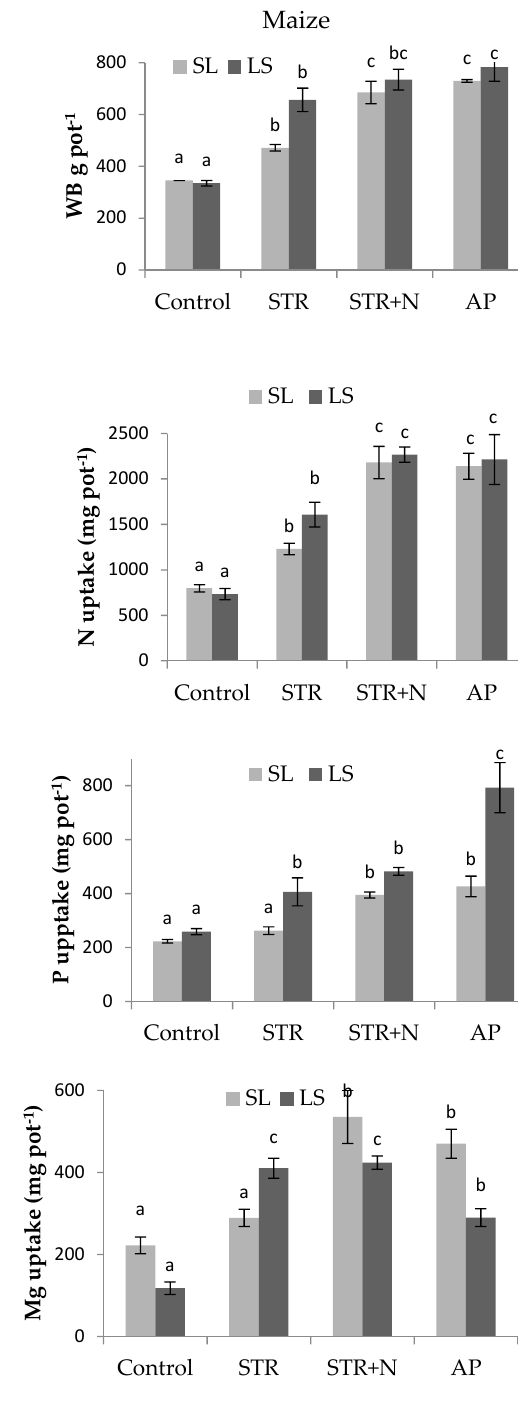
Figure 1. Yields (WB—Wet Basis) of maize and grass (sum of of three mowings) on two types of soil: silty loam (SL) and loamy sand (LS) and N, P, Mg uptake by crops on objects fertilized with: struvite from bio-refinery—STR; struvite from bio-refinery and ammonium sulfate (commercial)—STR + N; ammonium phosphate (commercial)—AP and on control treatment—without fertilization (Control). The standard deviation within each treatment (n = 3) is indicated by the line extending the column. (a–d) Homogeneous groups. Values followed by the same letters in the column (separately for soils: SL and LS) are not statistically different (Tukey HSD multiple range test, 95.0% significance, P < 0.05).